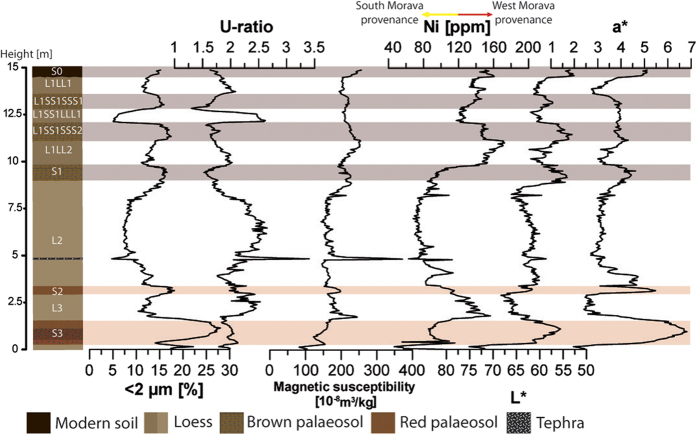
Clay fractions, U-ratio, χ, Ni contribution, L* and a* values (see Methods) related to pedostratigraphy of the composite profile from the Stalać section.